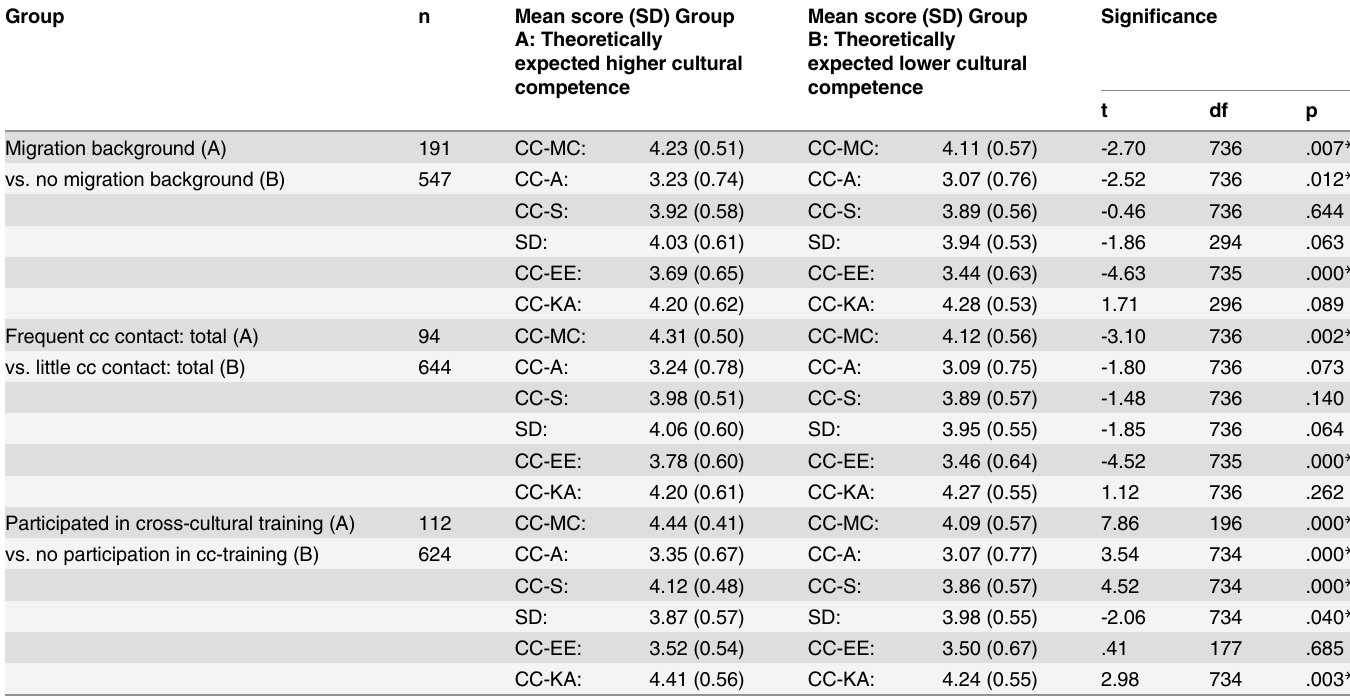
Mean score (SD) Group B: Theoretically